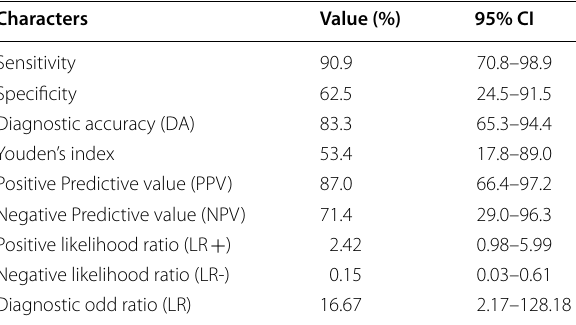
Table 12 Agreement between biopsy (reference) and MRI DCE